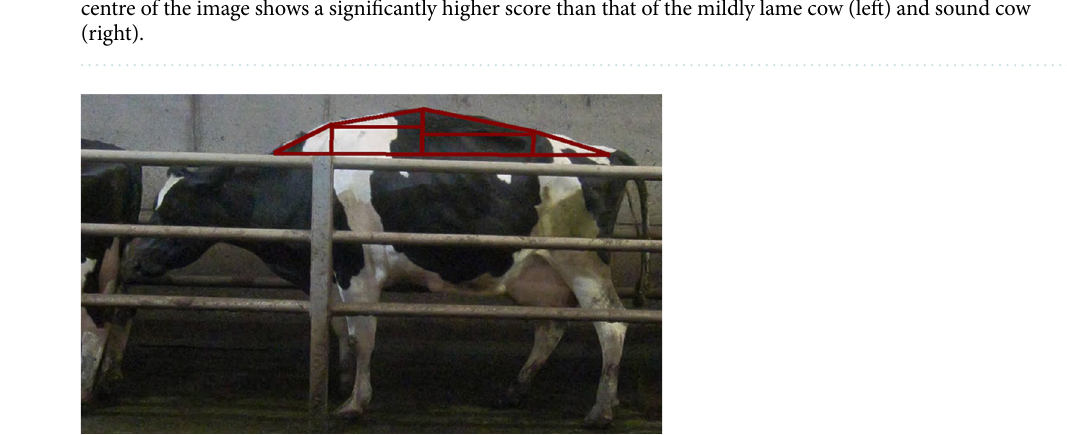
Figure 9. Visualization of how the area of the back is calculated by breaking it up into small sections and then summing the area of each of the